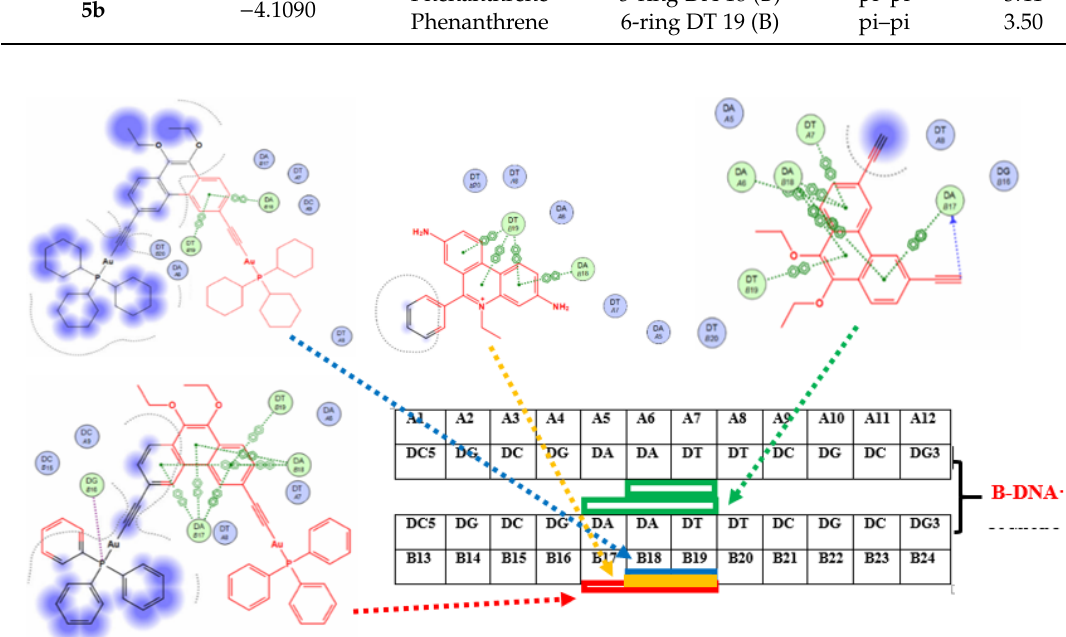
Figure 4. Illustration of the ct-DNA interactions of ethidium bromide, 4 , 5a, and 5b and their targeted nucleotides. Table 2. Docking study results for 4 , 5a, and 5b .